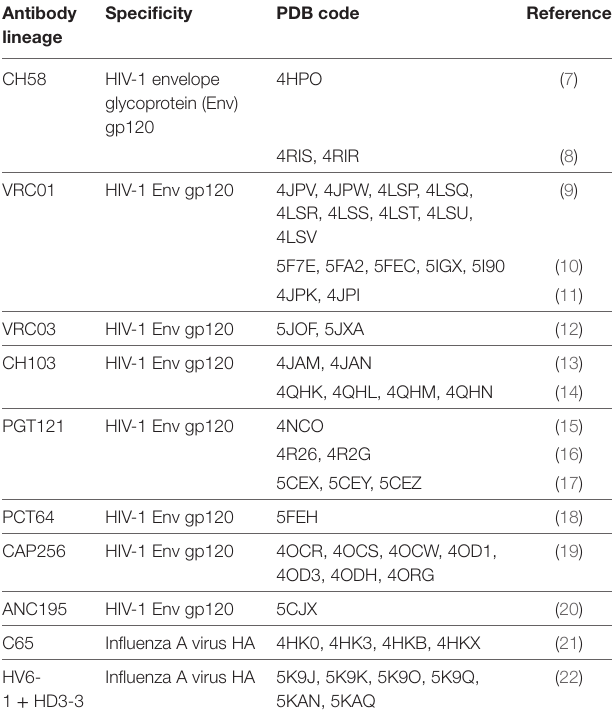
TABle 1 | Structural studies of antibody clonal lineages reconstructed using next-generation sequencing. Antibody